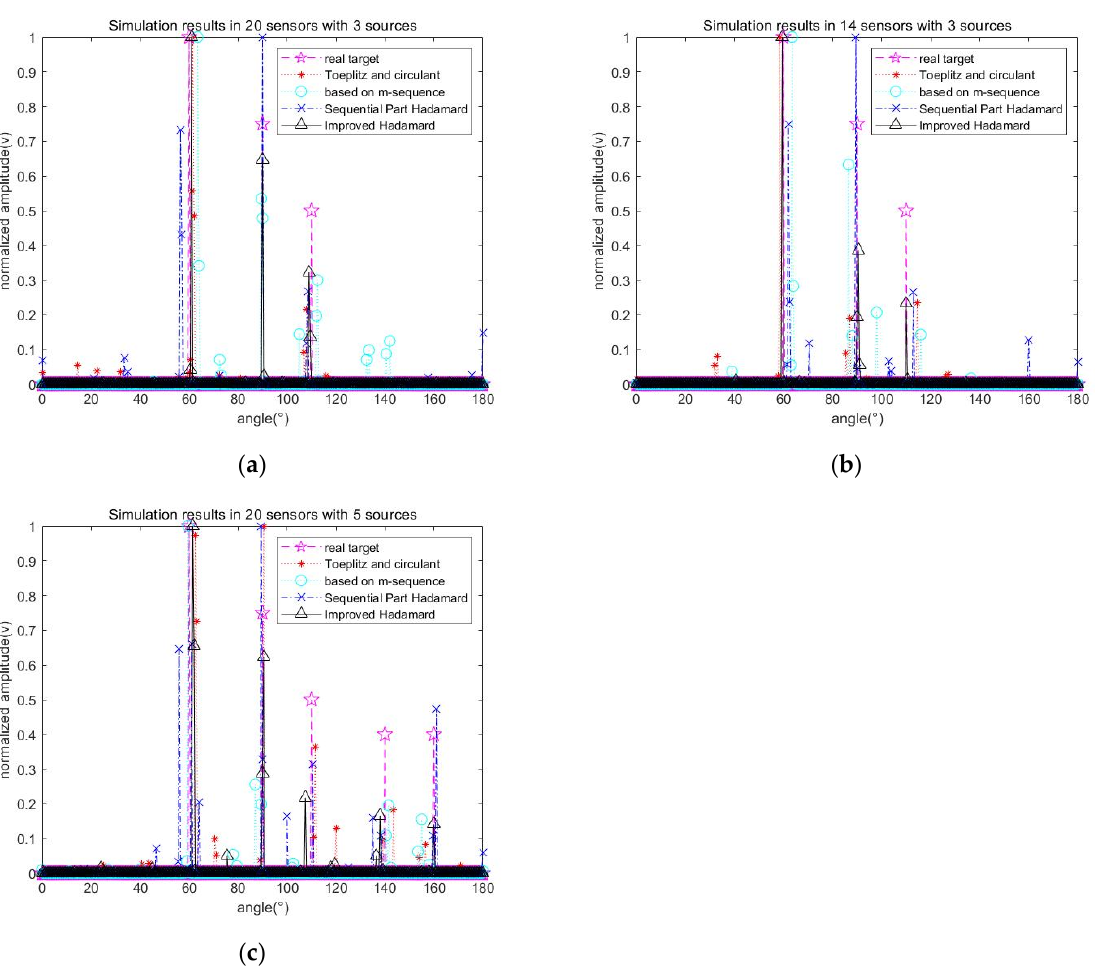
Figure 5. Simulation target reconstruction effect in different number of sensors and sources: ( a ) simulation results in 20 sensors with 3 sources; ( b ) simulation results in 14 sensors with 3 sources; and ( c ) simulation results in 20 sensors with 5 sources. Table 2. Simulation parameter changes.